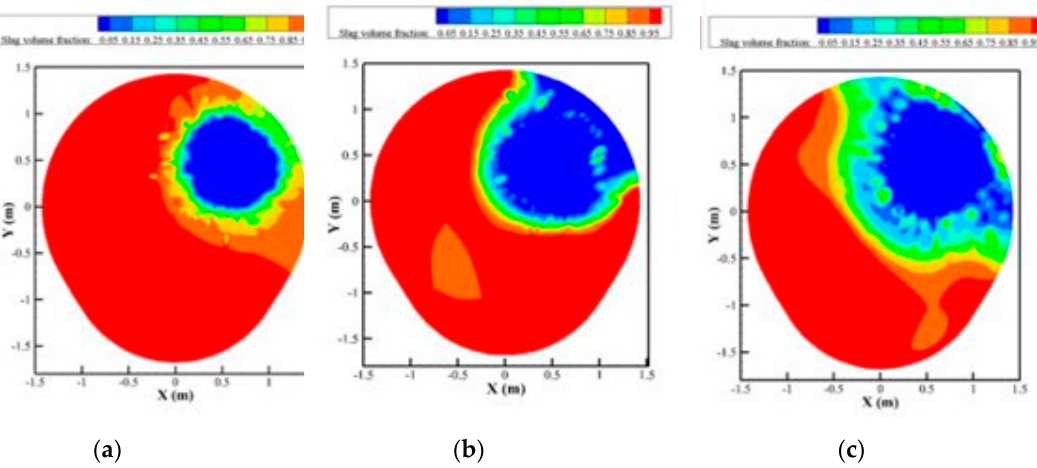
Figure 5. Open-eye size in the ladle from simulation results for a slag layer thickness of 40 cm: ( a ) Q = 200 NL/min, ( b ) Q = 400 NL/min, and ( c ) Q = 500 NL/min.